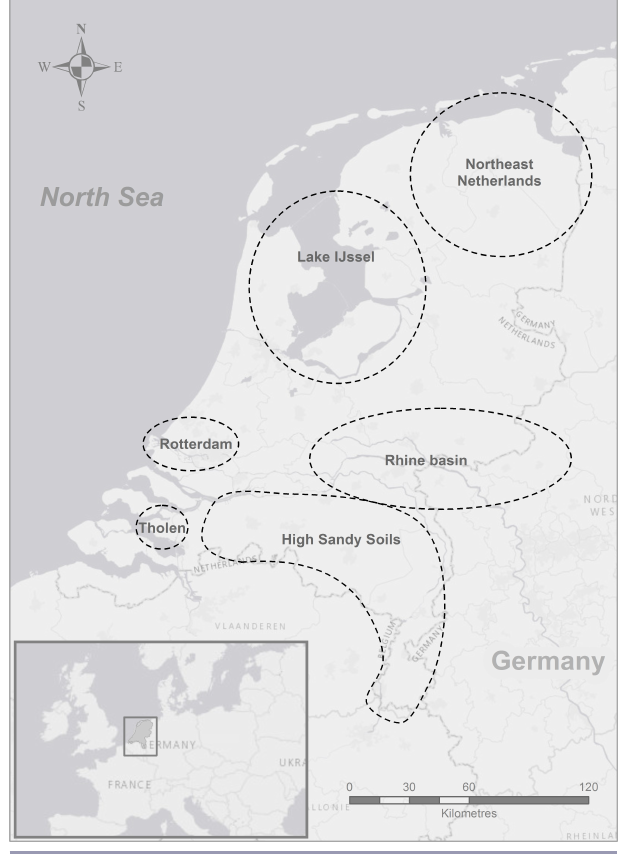
Fig. 1 . The location of the six adaptation